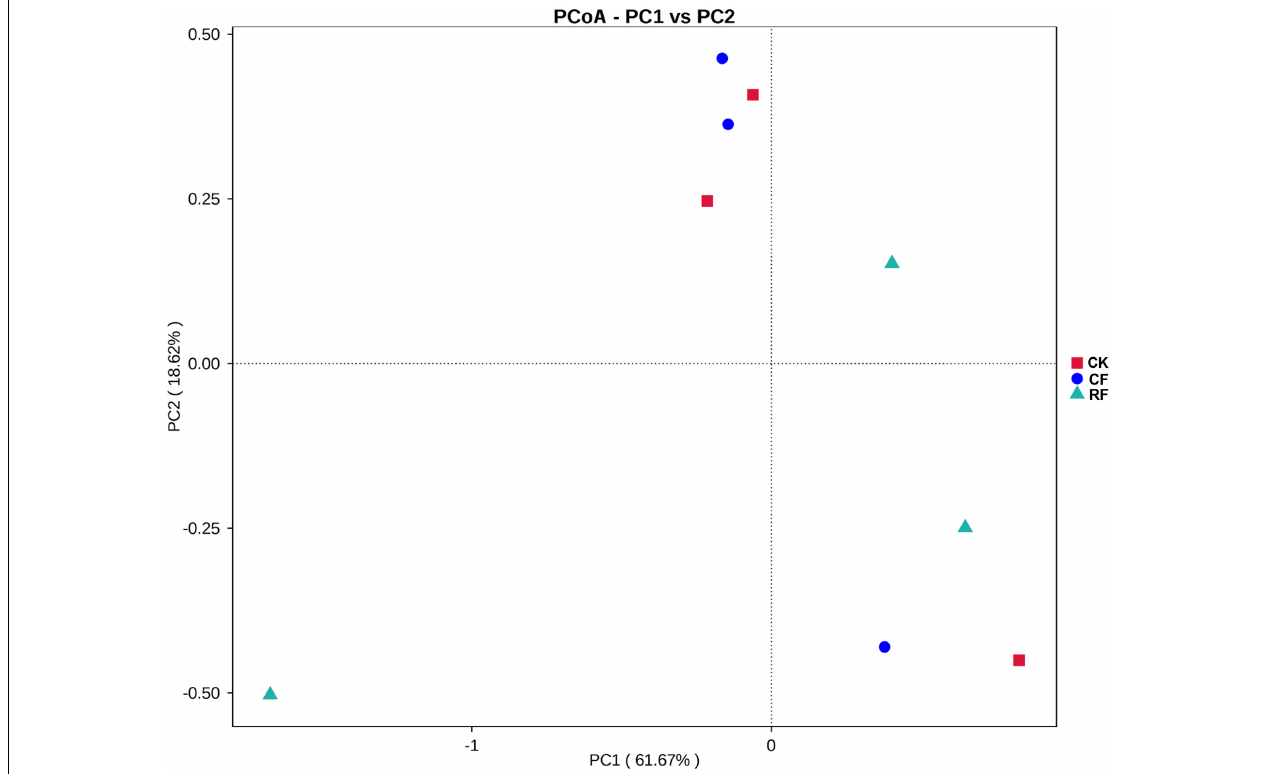
FIGURE 5 | Principal coordinate analysis of operational taxonomic units (OTUs) with different fertilization. CK, CF, and RF indicated without fertilizer applied, with compound fertilizer applied, and with reduced fertilizer applied, respectively.